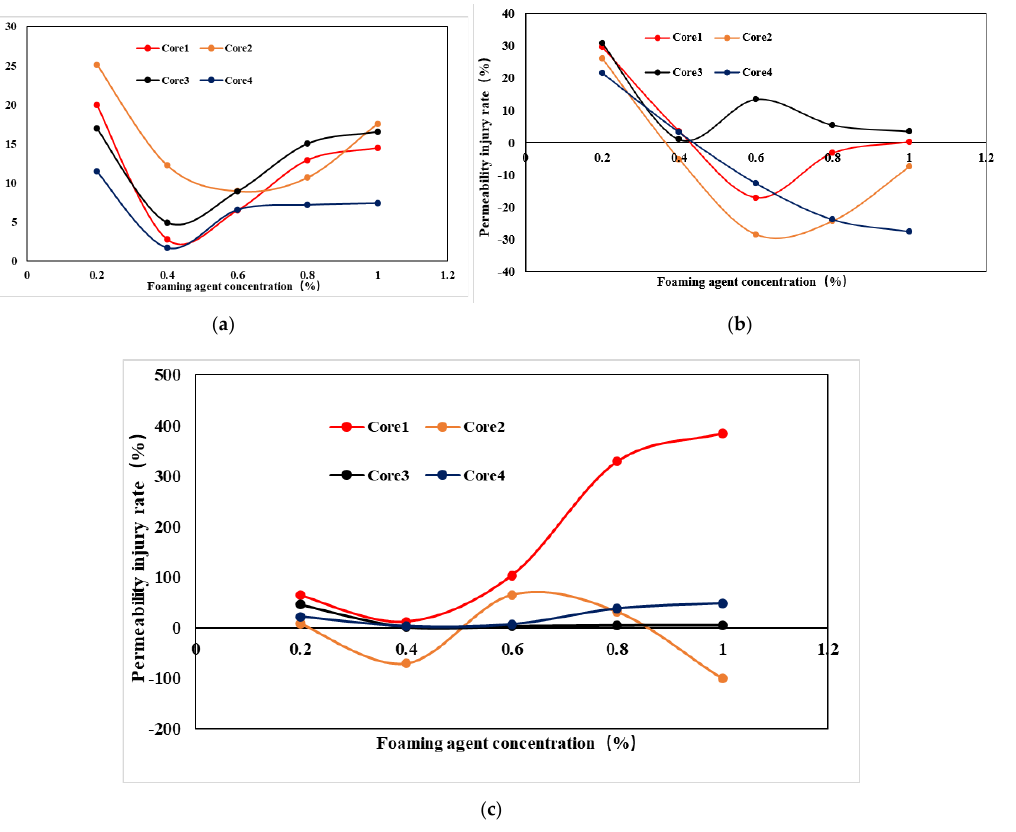
Figure 7. Damage rates of various pores with increasing foaming concentrations. ( a ) Minor pore; ( b ) Medium pore; ( c ) Macro pore. To evaluate and analyze the damage caused by different concentrations of foaming interfacial tension, caused by the change of foaming agent solution concentration, and the